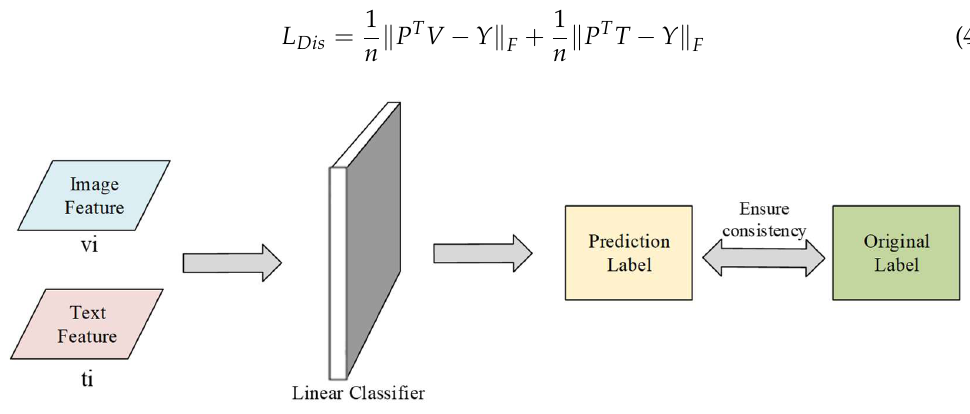
Figure 5. The framework for preserving the semantic information between the generated features and different modal samples.